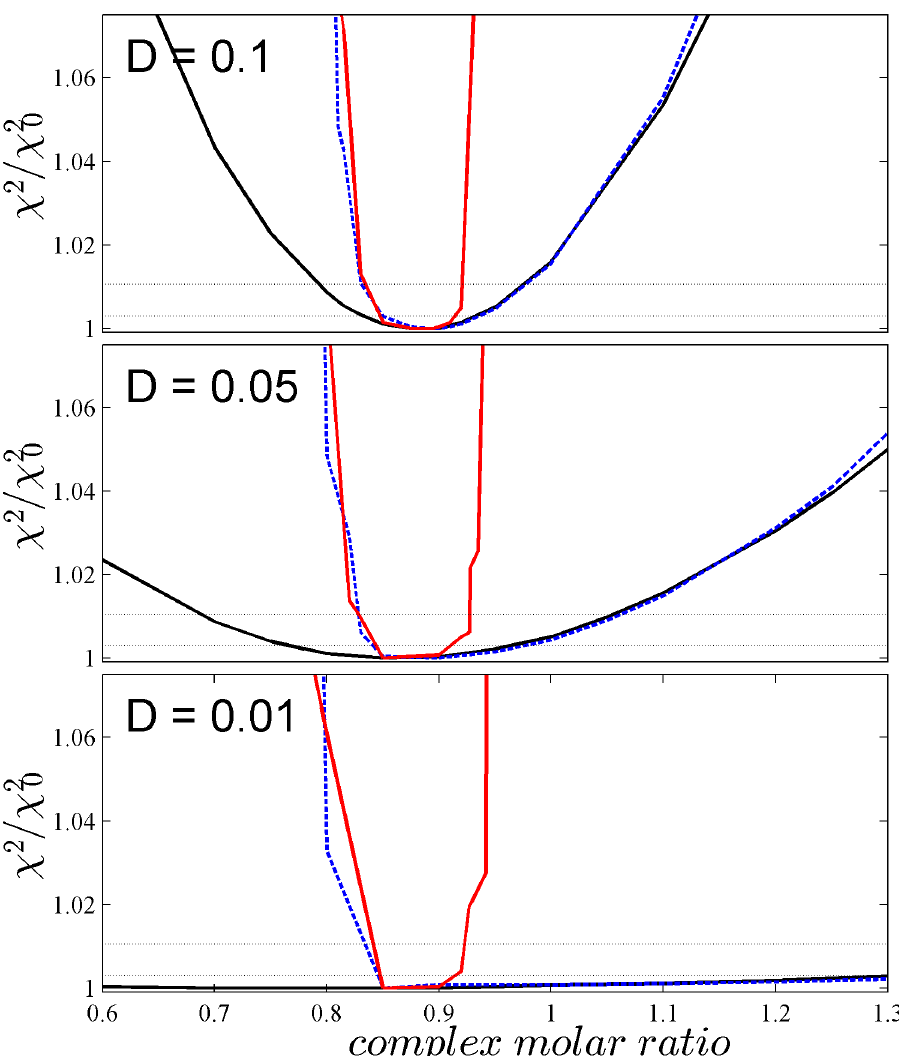
Figure 1. Information content of simulated sedimentation velocity data on the molar ratio in the complex, dependent on spectral properties and MSSV analysis constraints. Data were simulated for a rapid 1:1 interaction, as described in the Results, with a reaction boundary of composition A/B of 0.91. Raw sedimentation profiles for interference and absorbance detection are shown in Figure S1. Simulated were conditions with acceptable spectral discrimination with D norm =0.1 (top), and marginal spectral discrimination with D norm =0.05 (middle), and clearly insufficient D norm =0.01 (bottom), respectively. The MSSV analysis was conducted with a segmented c k ( s ) analysis with two different sedimentation coefficient ranges, each describing one of the clearly distinguishable boundaries of the sedimentation pattern: a first segment covering the range of low s -values including the s -value of the free smaller species and the undisturbed boundary, and a second segment covering the range of sedimentation coefficients of the larger free species and the complex (both of which are entirely engulfed in the reaction boundary of coupled co-transport, which forms a single c k ( s ) peak in this segment). To probe the statistical accuracy of the molar ratio values in the MSSV analysis, the high- s segment allowed only for a single class of species with pre-constrained molar ratio. Plotted is the quality of fit, quantified as the ratio of the x 2 obtained and the best-fit x 2 0 , as a function of the molar ratio of the high- s segment. For each D norm value, shown are the results from a standard MSSV analysis (black solid line), the MC-MSSV analysis (blue dotted line), and the MC-MSSV additionally constrained by the absence of component B from the low- s segment (solid red line). For orientation, the x 2 / x 2 0 levels corresponding to P -values of one standard deviation (at 1.003) or two standard deviations (at 1.011) by F -statistics are indicated by thin dotted horizontal